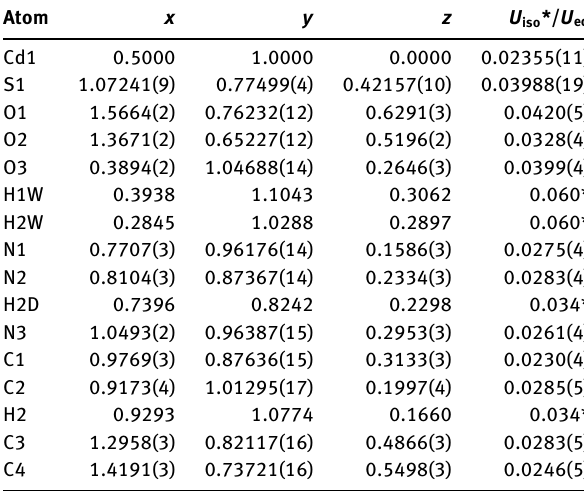
Table 2: Fractional atomic coordinates and isotropic or equivalent isotropic displacement parameters (Å 2